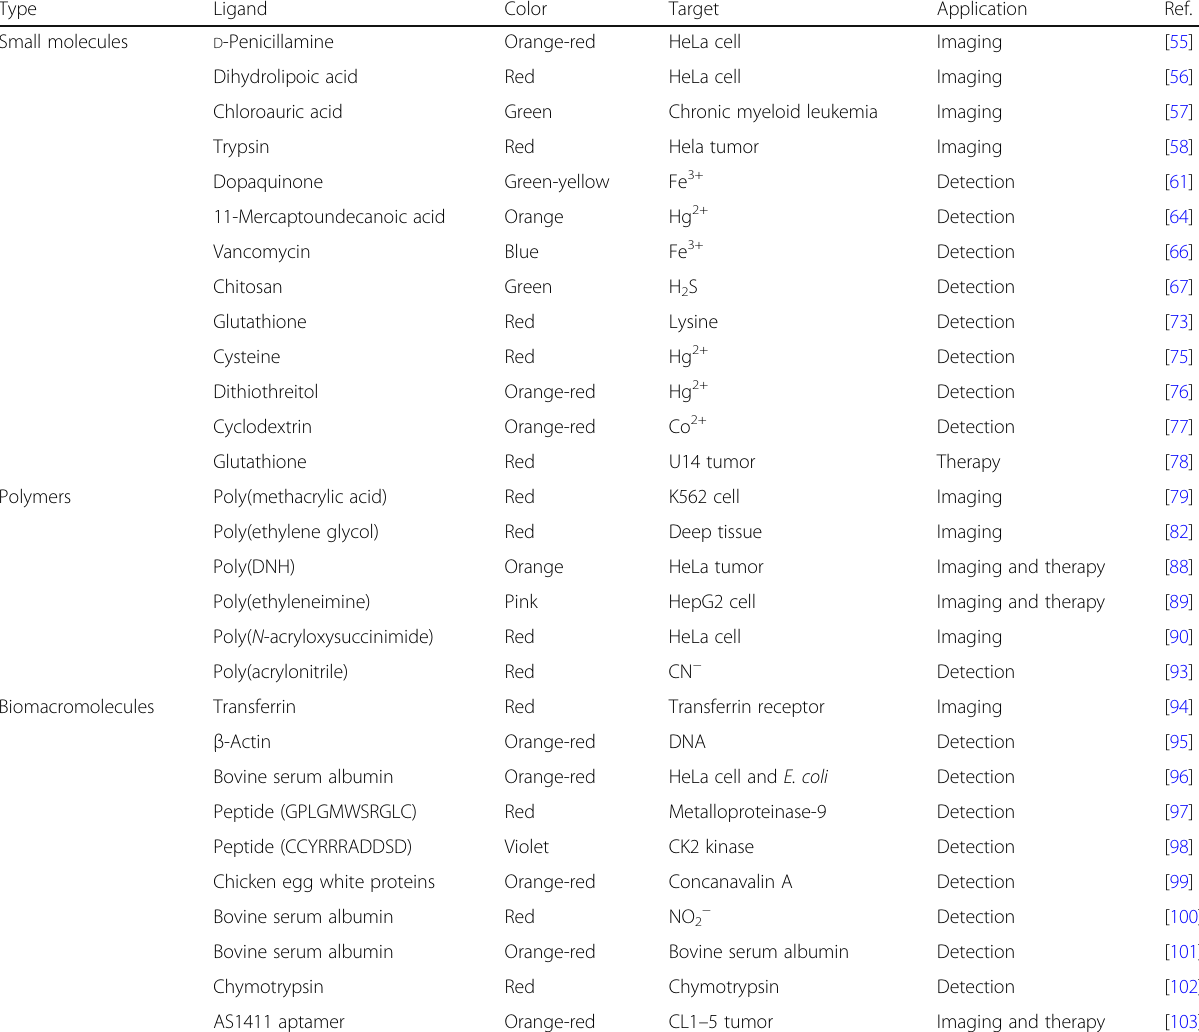
Table 1 Colors, detection targets, and applications of AuNCs with various ligands in this review